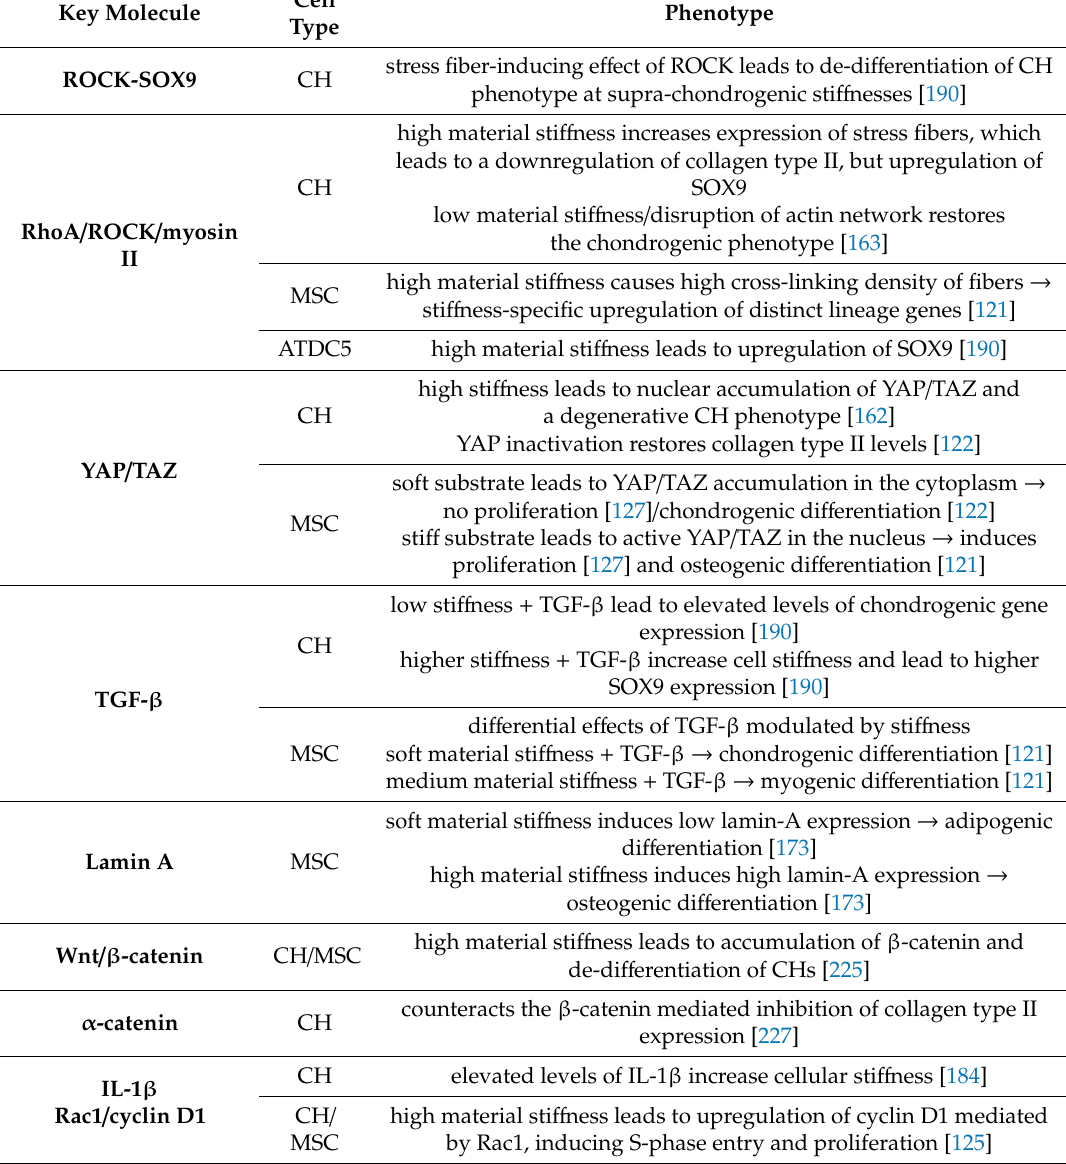
Table 3. Key molecules that regulate the material sti ff ness-dependency of cell